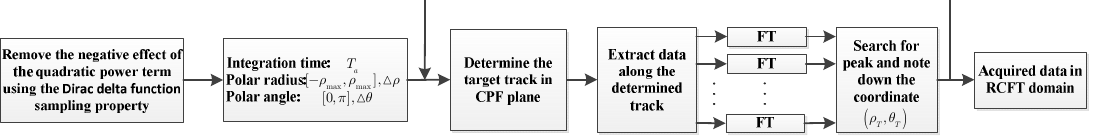
Figure 4. Comparison results of the three methods. ( a ) The slice obtained by the Hough-GHAF, RCT, and the proposed RCFT methods at SNR = 5 dB; ( b ) the slice obtained by the Hough-GHAF, RCT, and the proposed RCFT methods at SNR = –5 dB.